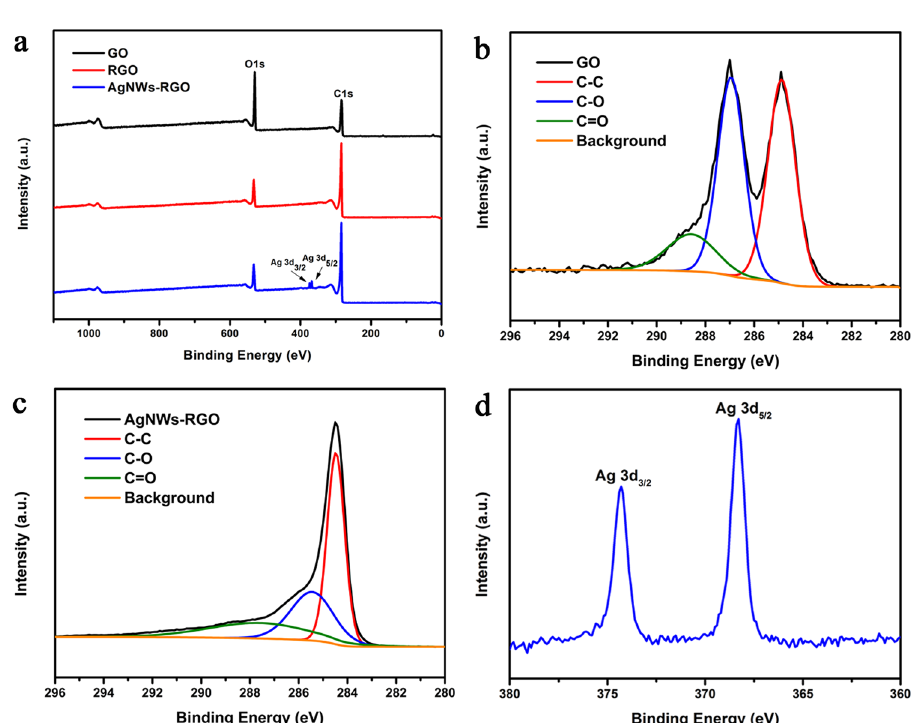
Figure 6. ( a ) XPS spectra of pristine GO and RGO sheets stripped from the PG, and RGO/AgNWs (1:1). ( b ) C 1s spectra of GO. ( c ) C 1s spectra of RGO/AgNWs (1:1). ( d ) Ag 3d spectra of RGO/AgNWs